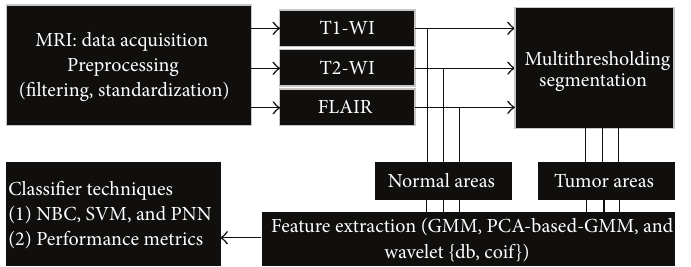
Figure 2: Schematic diagram of the proposed method for automatic feature